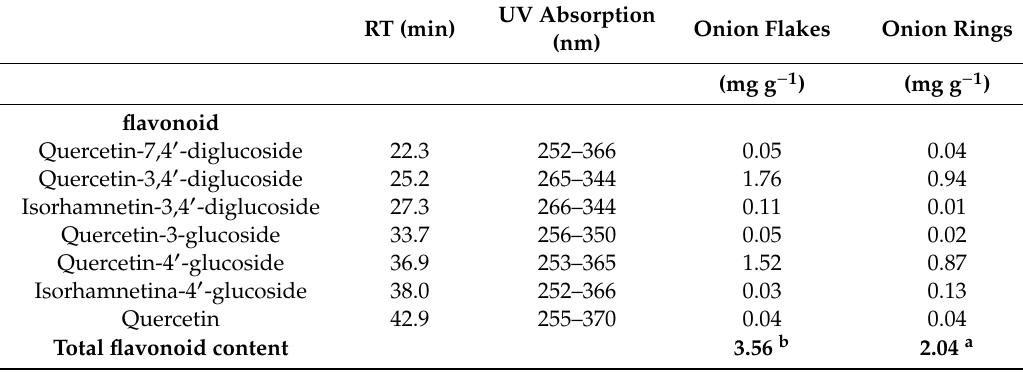
Table 4. Quali-quantitative flavonols content, expressed as mg rutin mg g − 1 . Data are the mean of three independent determination (Standard Deviation < 5%). For the total flavonoid content, di ff erent superscript letters (a, b) indicate significant di ff erence at p <